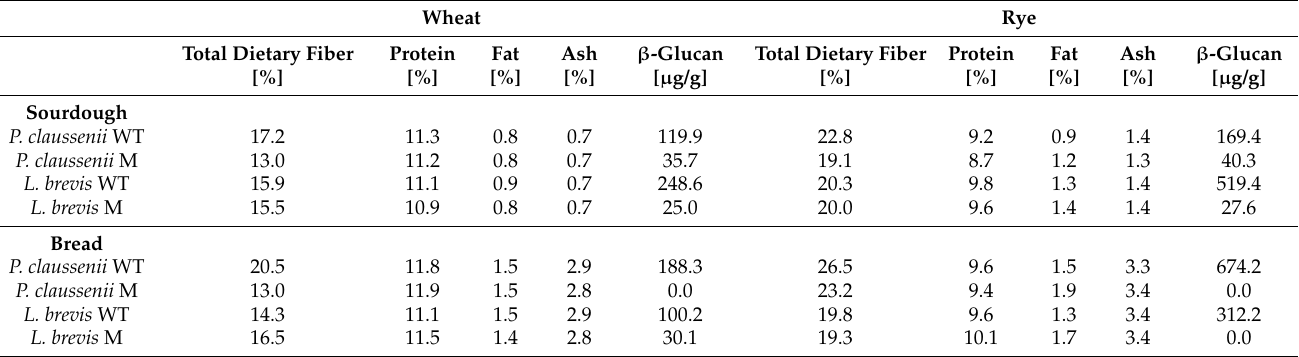
Table 2. Nutrient composition of sourdoughs and breads obtained from fermentations with lactic acid